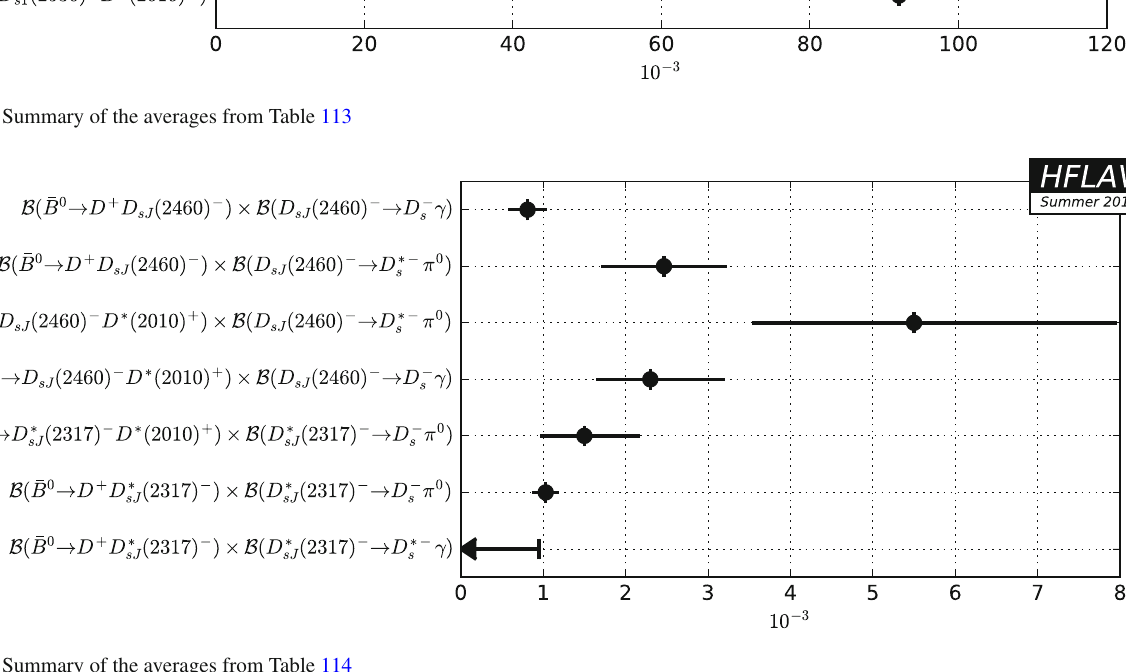
Fig. 88 Summary of the averages from Table